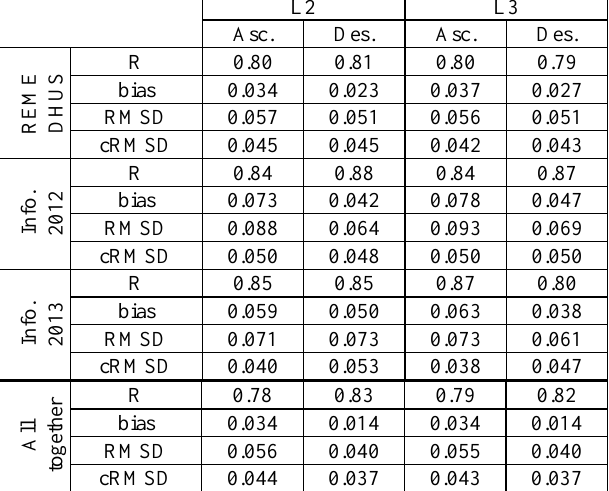
Table 2. Results of the comparison between the spatially averaged series of soil moisture for the three networks in each usable time series.